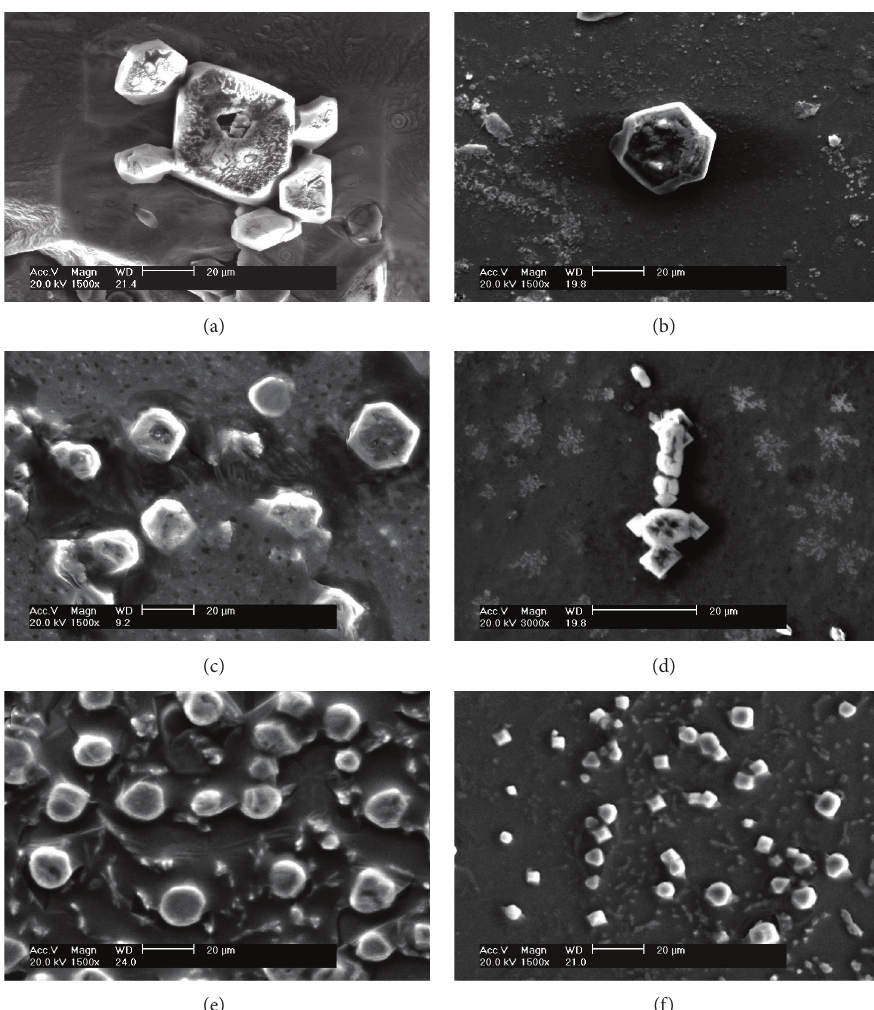
Figure 1: SEM images of representative urinary crystals from patients with CaOx renal calculi after oral administration of K 3 cit for one week. Scale bar: 20 𝜇